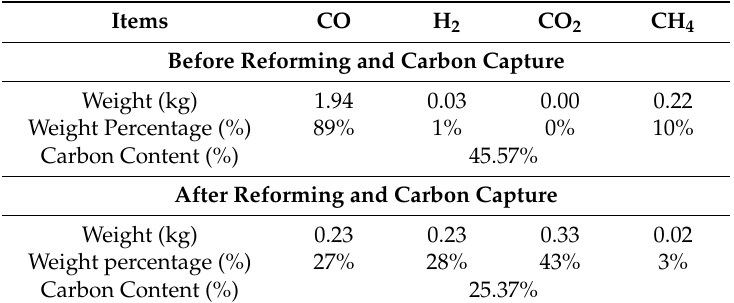
Table 5. Composition of syngas before and after pre-combustion carbon